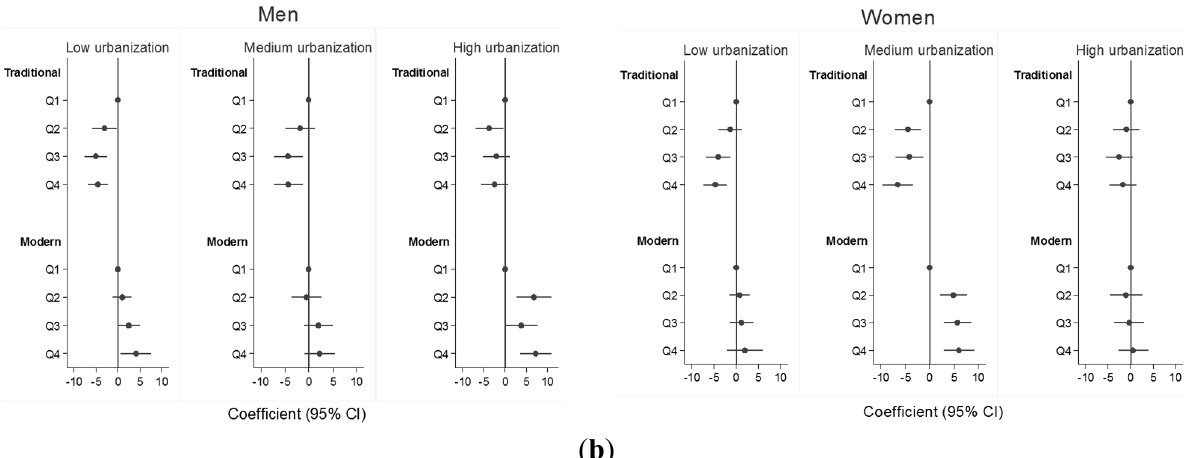
Figure 2. Dietary pattern and BMI/WC by gender, across three urbanization levels *. (* After adjusting for age, marital status, work status, education level, smoking, physical activity and energy). ( a ) Dietary pattern and BMI; ( b ) dietary pattern and WC.